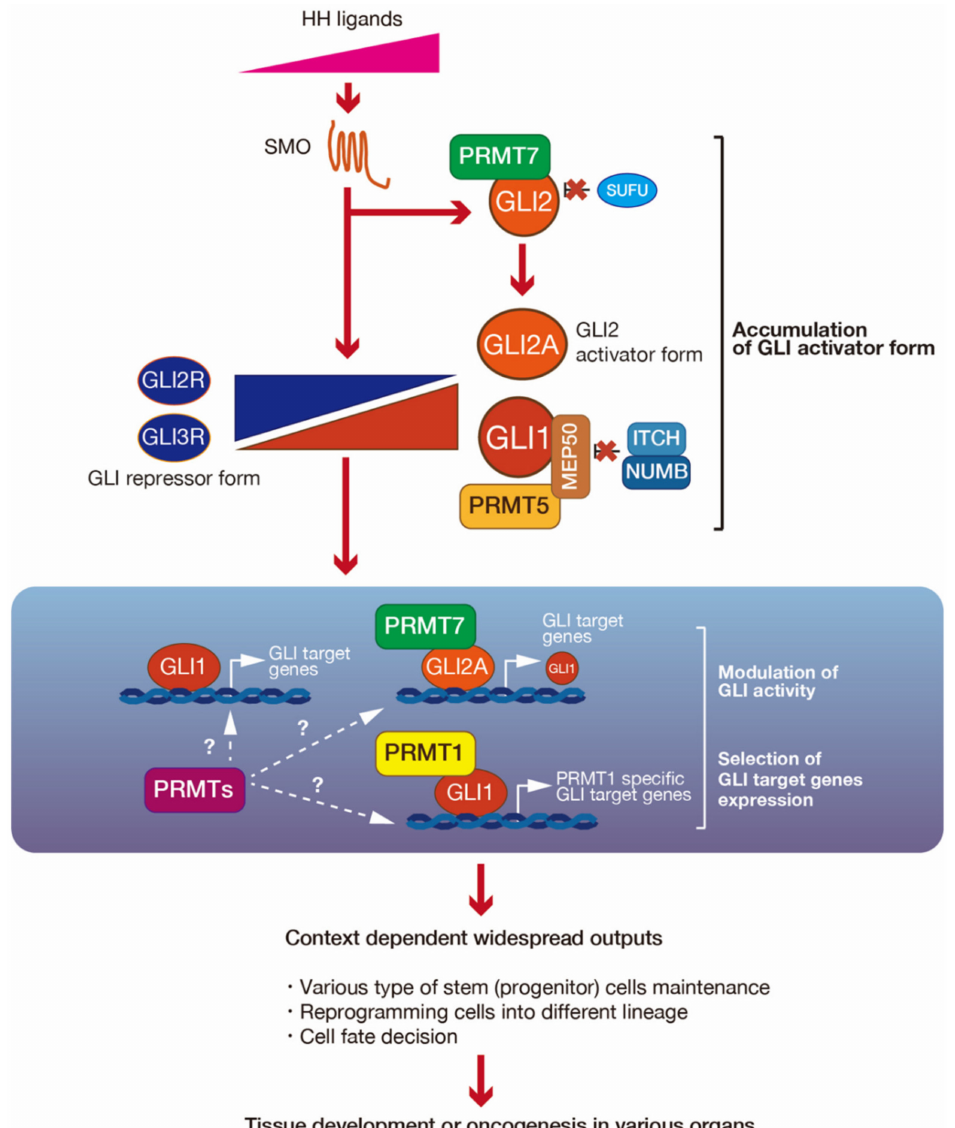
Figure 5. Possible roles of glioma-associated oncogene (GLI) 1 and GLI2 regulation by protein